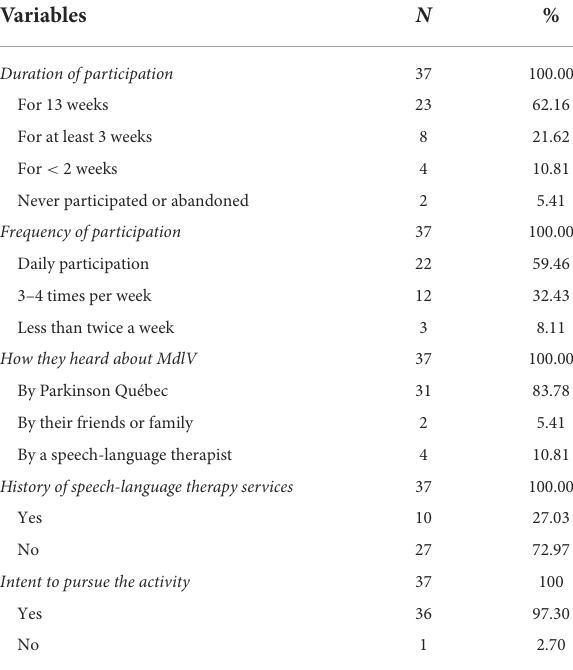
TABLE 1 Participants’ level of participation in MdlV and history of previous SLT